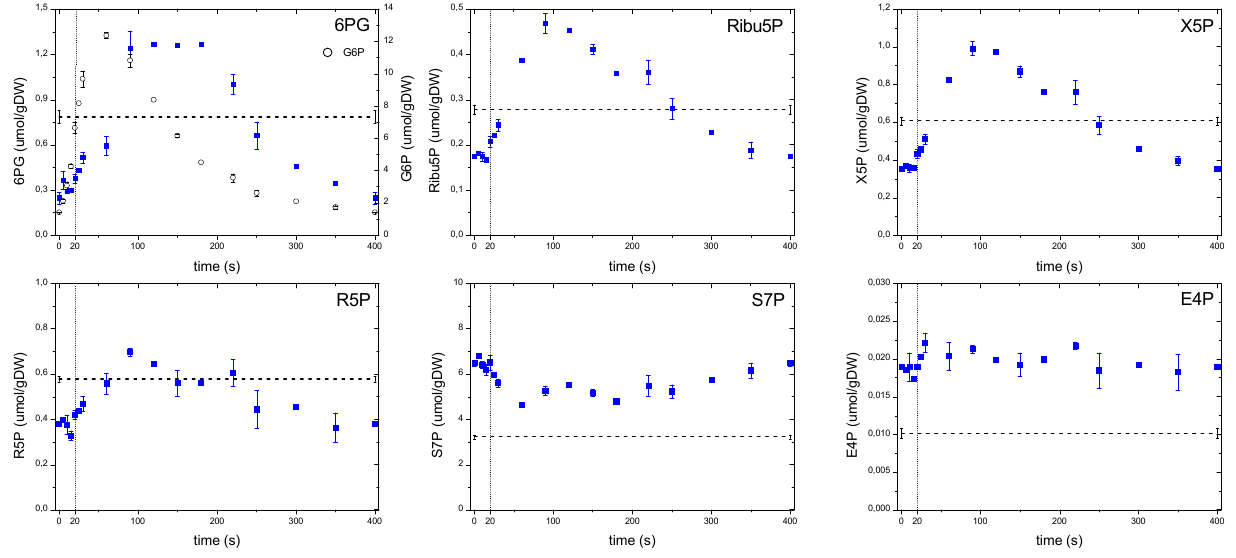
Figure 6. Concentration measurements of the PPP metabolites during the feast/famine cycle. The dashed line represents the reference steady-state (D = 0.1 h − 1 ), error bars represent the standard error of duplicate determination during two subsequent cycles. The vertical dotted line represents the end of the feeding